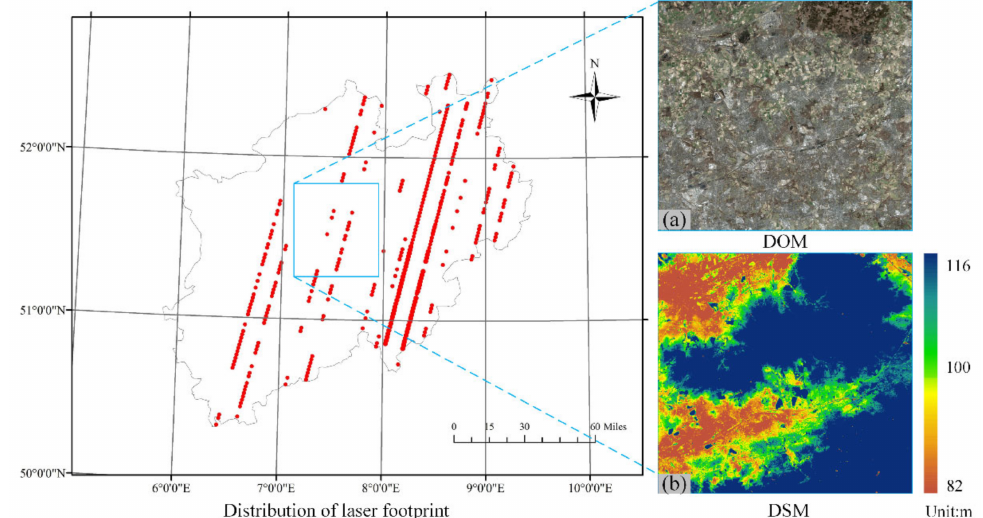
Figure 9. Regional distributions of laser data and verification data in North Rhine-Westphalia, Germany. ( a ) is DOM data obtained by aerial photography in the experiment area; ( b ) is DSM data for LIDAR points cloud acquired in the same